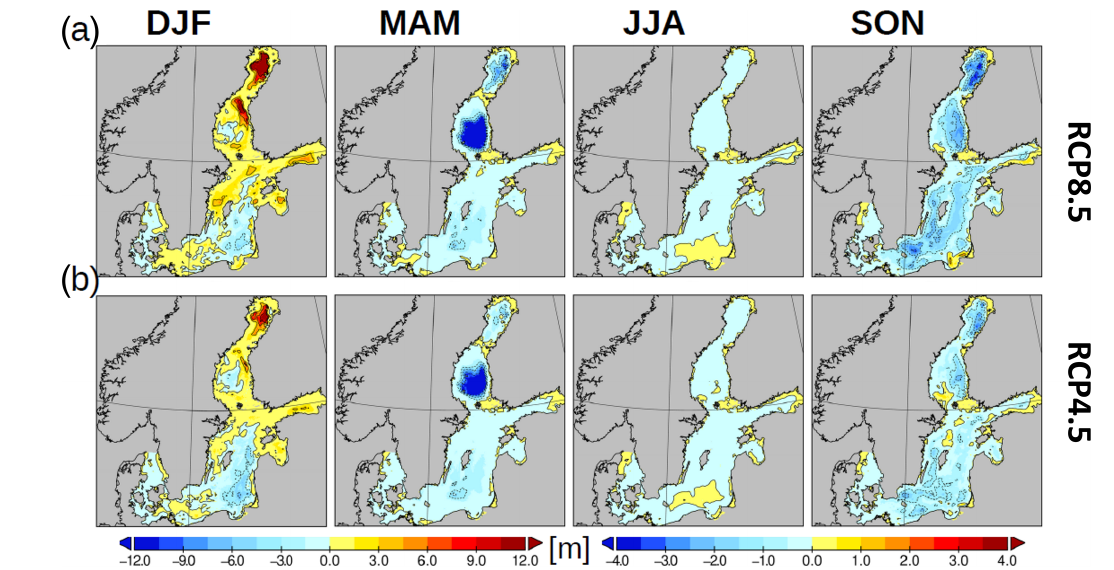
Figure 17. Mixed-layer depth calculated according to the criterion of de Boyer Montégut et al. (2004). Shown are the ensemble average changes of four different ESMs between 1976–2005 and 2069–2098 with the mean sea level rises (a) 0.90m (RCP8.5) and (b) 0.54m (RCP4.5). (Data source: Meier et al.,